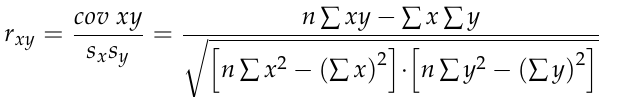
Figure 3. The composition of the respondents.